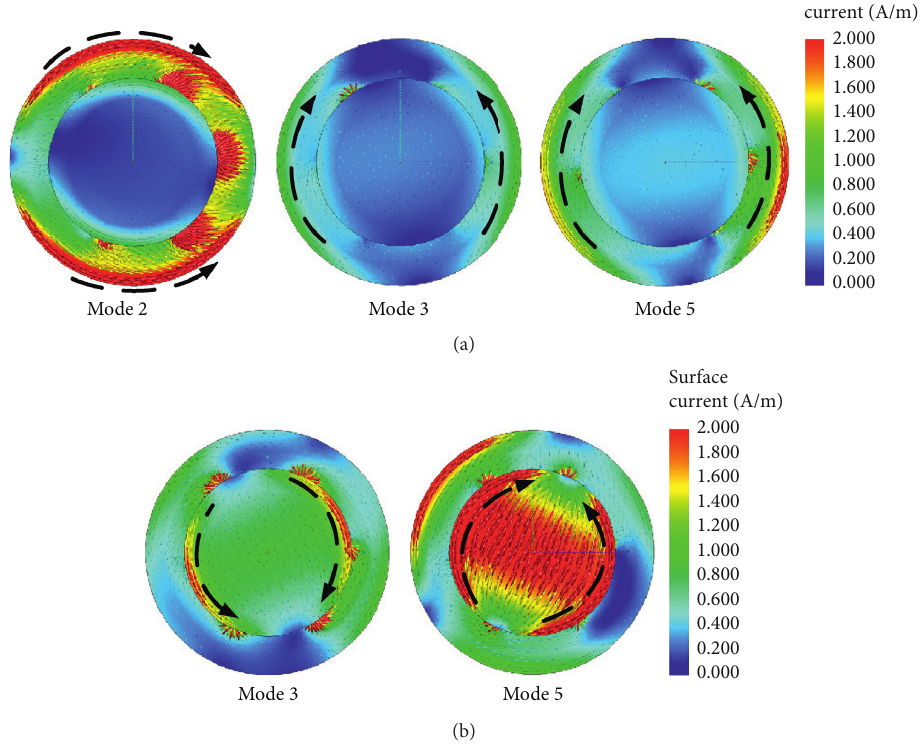
Figure 14: Modal current distribution of the antenna with six probes at (a) 1.72GHz and (b) 1.96GHz.